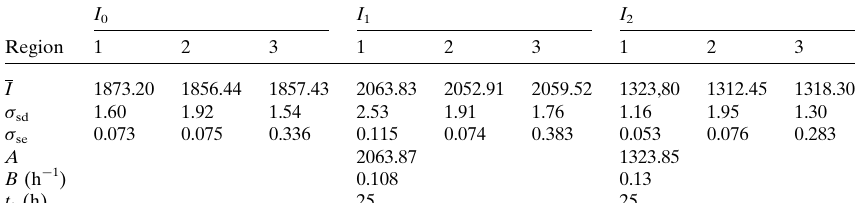
Table 1 Dark current dependence upon